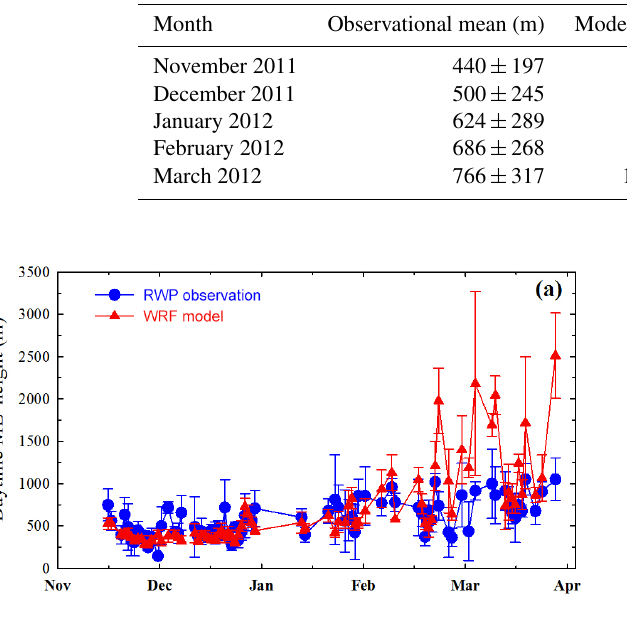
Table 2. Daytime (05:00–10:00UTC) monthly mean and percentage bias between RWP measurements and WRF simulations.